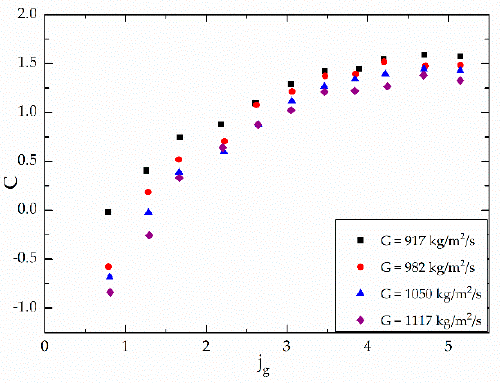
Figure 10. Variation of C under different mass velocities, versus superficial gas flux, j g , for q = 20.72 kW/m 2 .